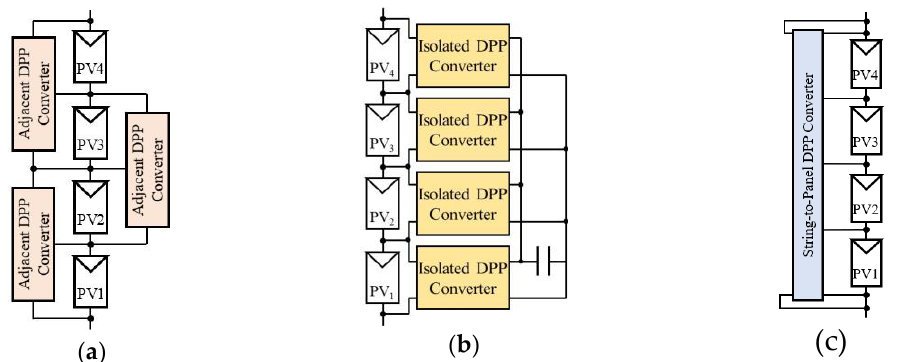
Figure 2. Differential power processing (DPP) architectures: ( a ) Adjacent panel-to-panel architecture; ( b ) Panel-to-panel with isolated port architecture; ( c ) String-to-panel architecture.